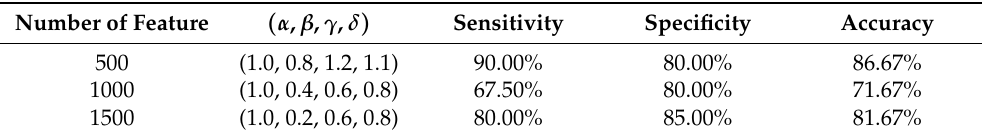
Figure 8. Classification accuracy against number of feature used for the binary-class model. Table 1. Statistics of the classification accuracy of the proposed model including all three classes using different numbers of features.